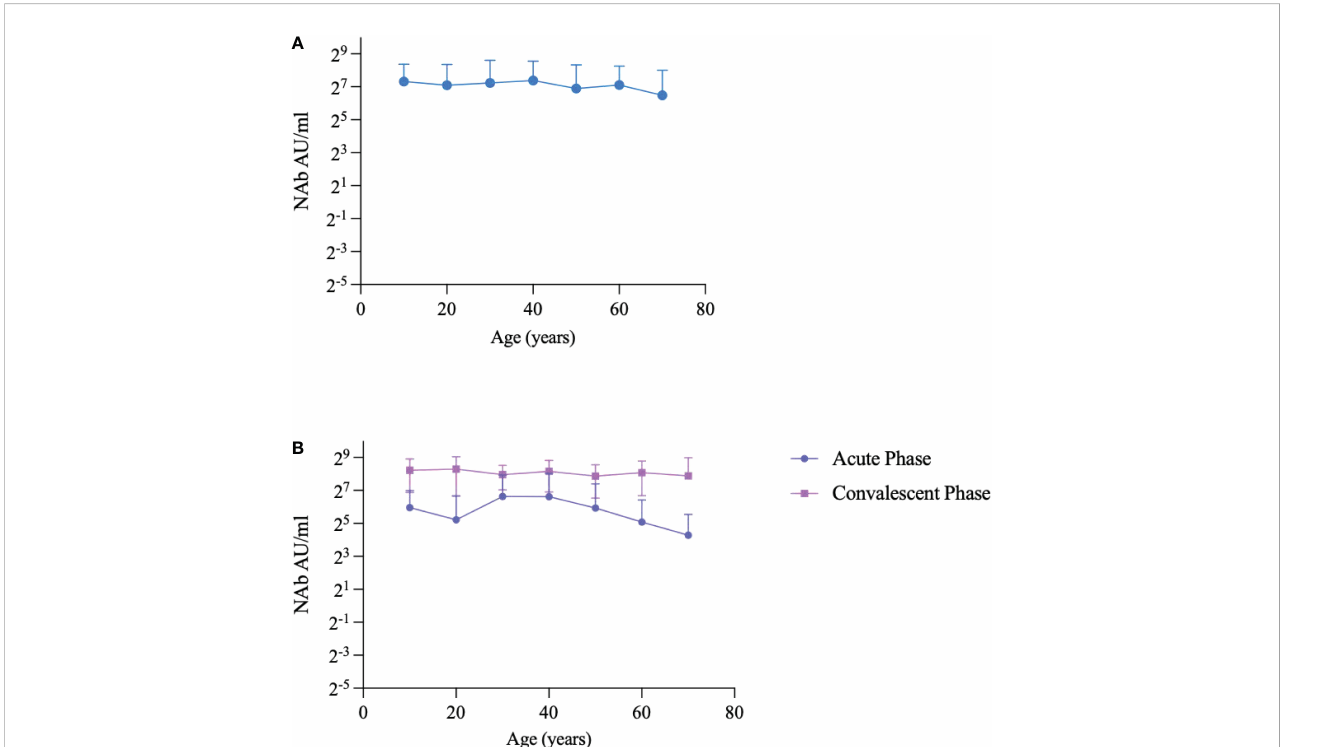
FIGURE 3 Changes in NAbs with age. (A) Changes in NAbs with age in breakthrough cases. (B) Changes in NAbs with age during the acute phase and convalescent phase. Each circle and triangle represent the titer for a serum sample. Note: Breakthrough cases were included from February 14, 2022, to May 30, 2022, post-immunized groups were recruited from August 10, 2021, to August 20,